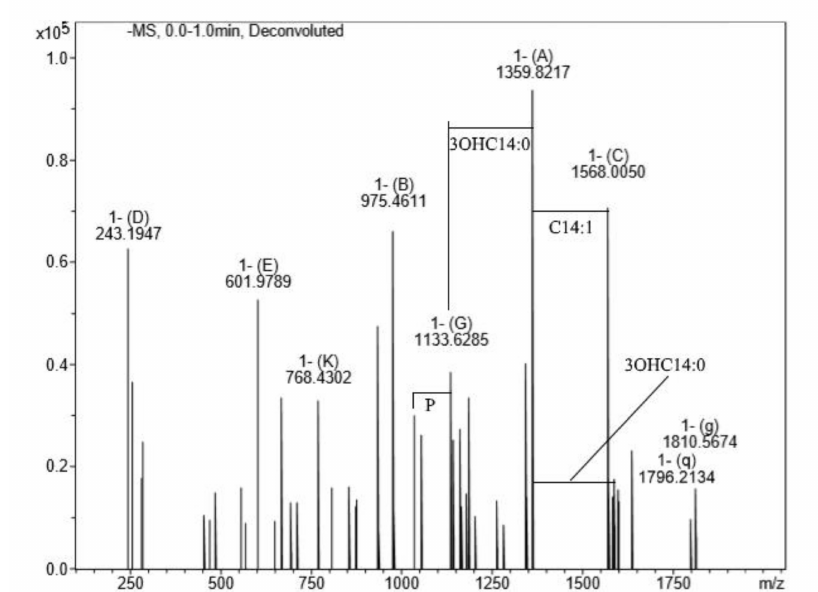
Figure 2. The mass spectrum of P. agglomerans 8488 lipid A. The major peak at m / z 1796.21 was assigned to the biphosphorylated hexaacylated species with fatty acid composition as follows: four 14:0